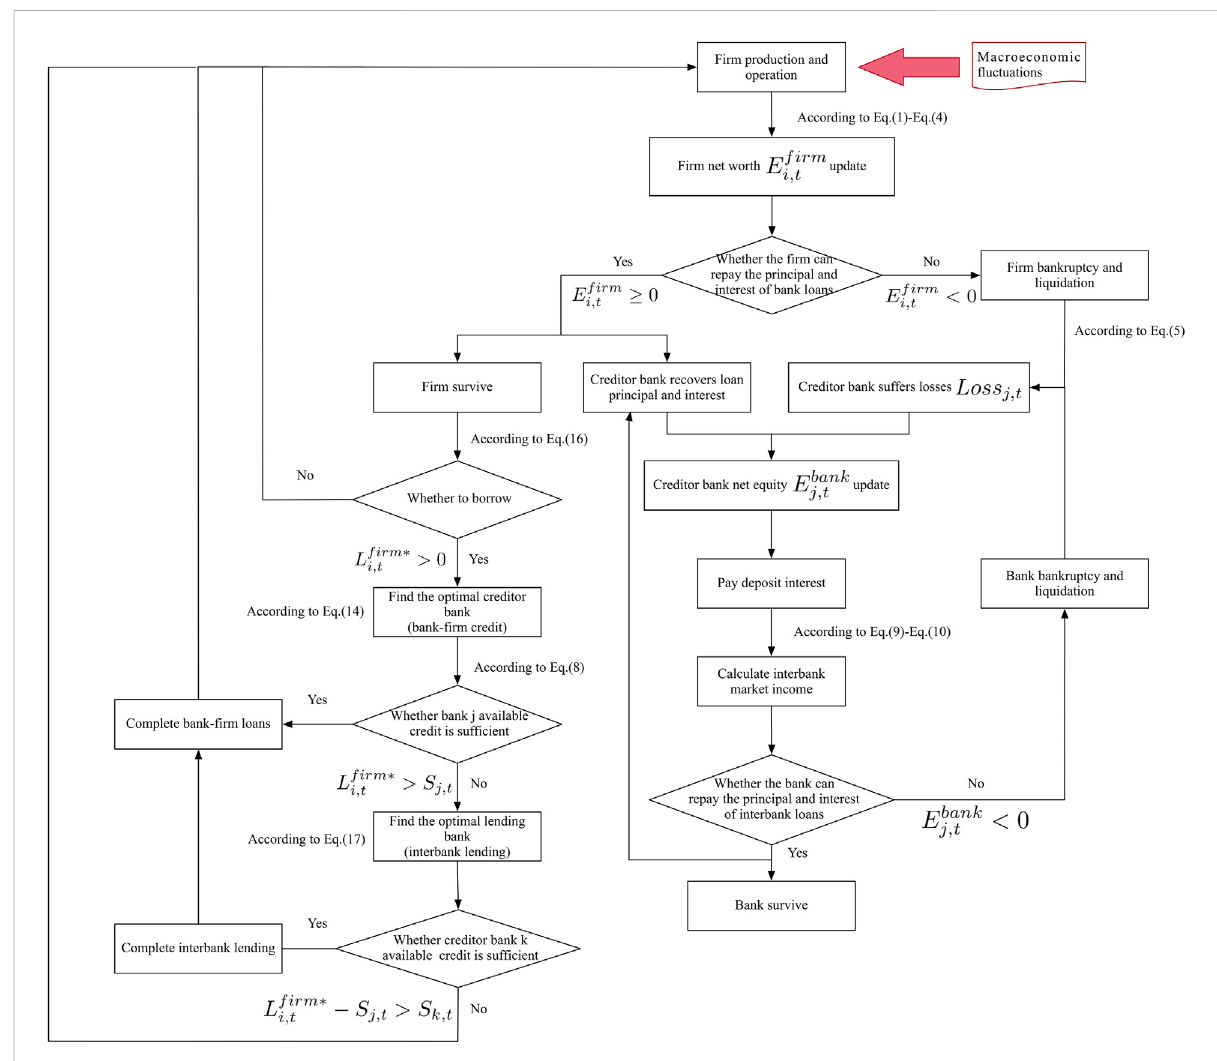
FIGURE 2 The dynamic evolution process of the multi-layer fi nancial network